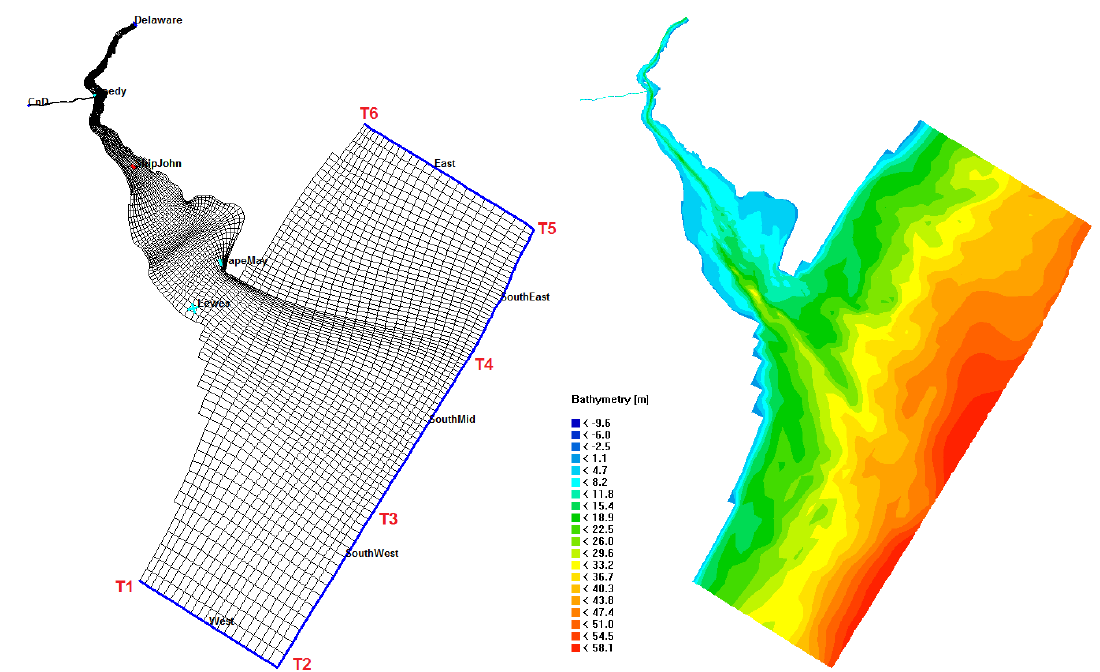
Figure 2. Overall domain grid cell resolution, bathymetry and